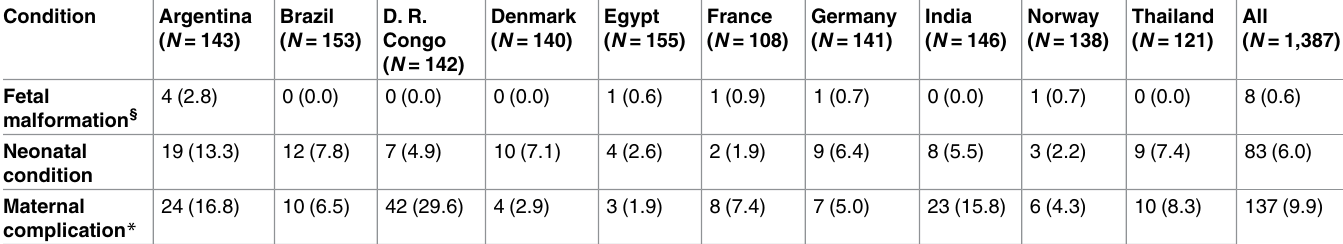
of countries (D. R. Congo, Egypt, and Thailand) with birthweight a median 400 g less than that of Norway, and lastly India, with birthweight 500 g less. The differences in birthweight between countries were highly significant for all percentiles ( p < 0.001 for all). When adjusted for gestational age at birth, the differences were still significant for all the percentiles ( p = 0.0018 for the 5th percentile and p < 0.001 for the 10th, 25th, 50th, 75th, 90th, and 95th per- centiles). The estimated birthweight according to neonatal sex and gestational age is shown in Table 4.